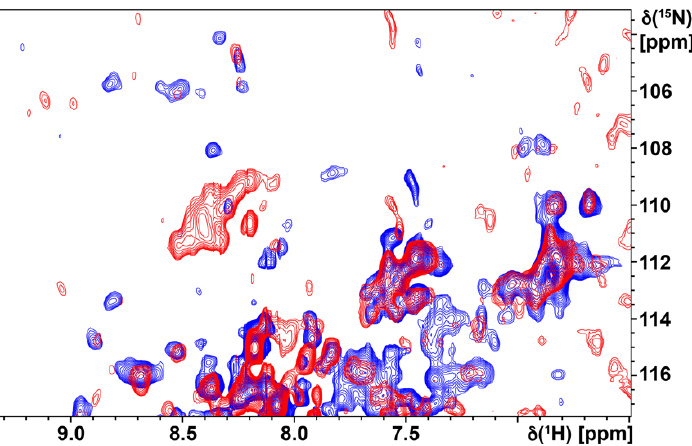
Figure 7. A superposition is presented of the TROSY spectra of u- 15 N H 1 R in complex with doxepin (blue) and histamine (red), showing an expanded view where signals from glycine and threonine 1 H– 15 N amide signals are typically observed.